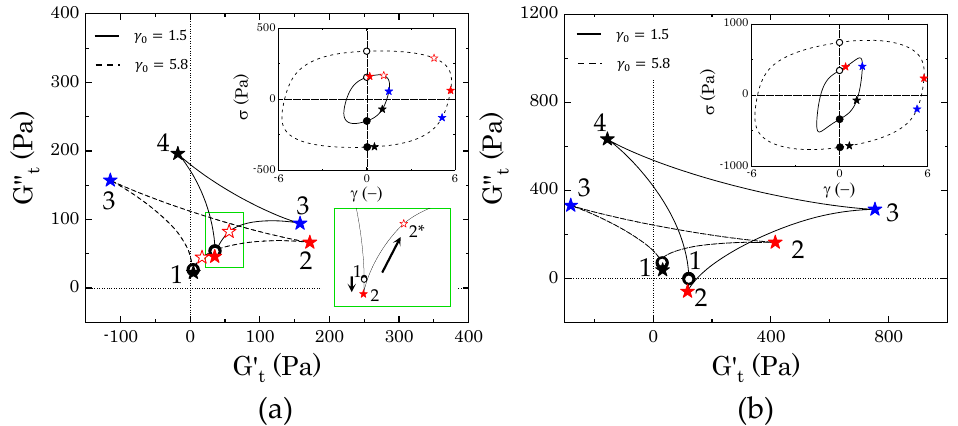
Figure 11. ( a ) Cole-Cole plot obtained at γ 0 = 1.5 (solid line) and 5.8 (dashed line) (shear-thinning region of the loss modulus) for sample M0 at 2% wt of Carbopol. ( b ) Cole–Cole plot obtained at γ 0 = 1.5 (solid line) and 5.8 (dashed line) (shear-thinning region of the loss modulus) for sample M2 at 2% wt of Carbopol. The insets show the corresponding elastic Lissajous–Bowditch plot (i.e., stress vs. strain) for reference. The green inset in panel a) zooms closer to the initial steps of the trajectory found for γ 0 =